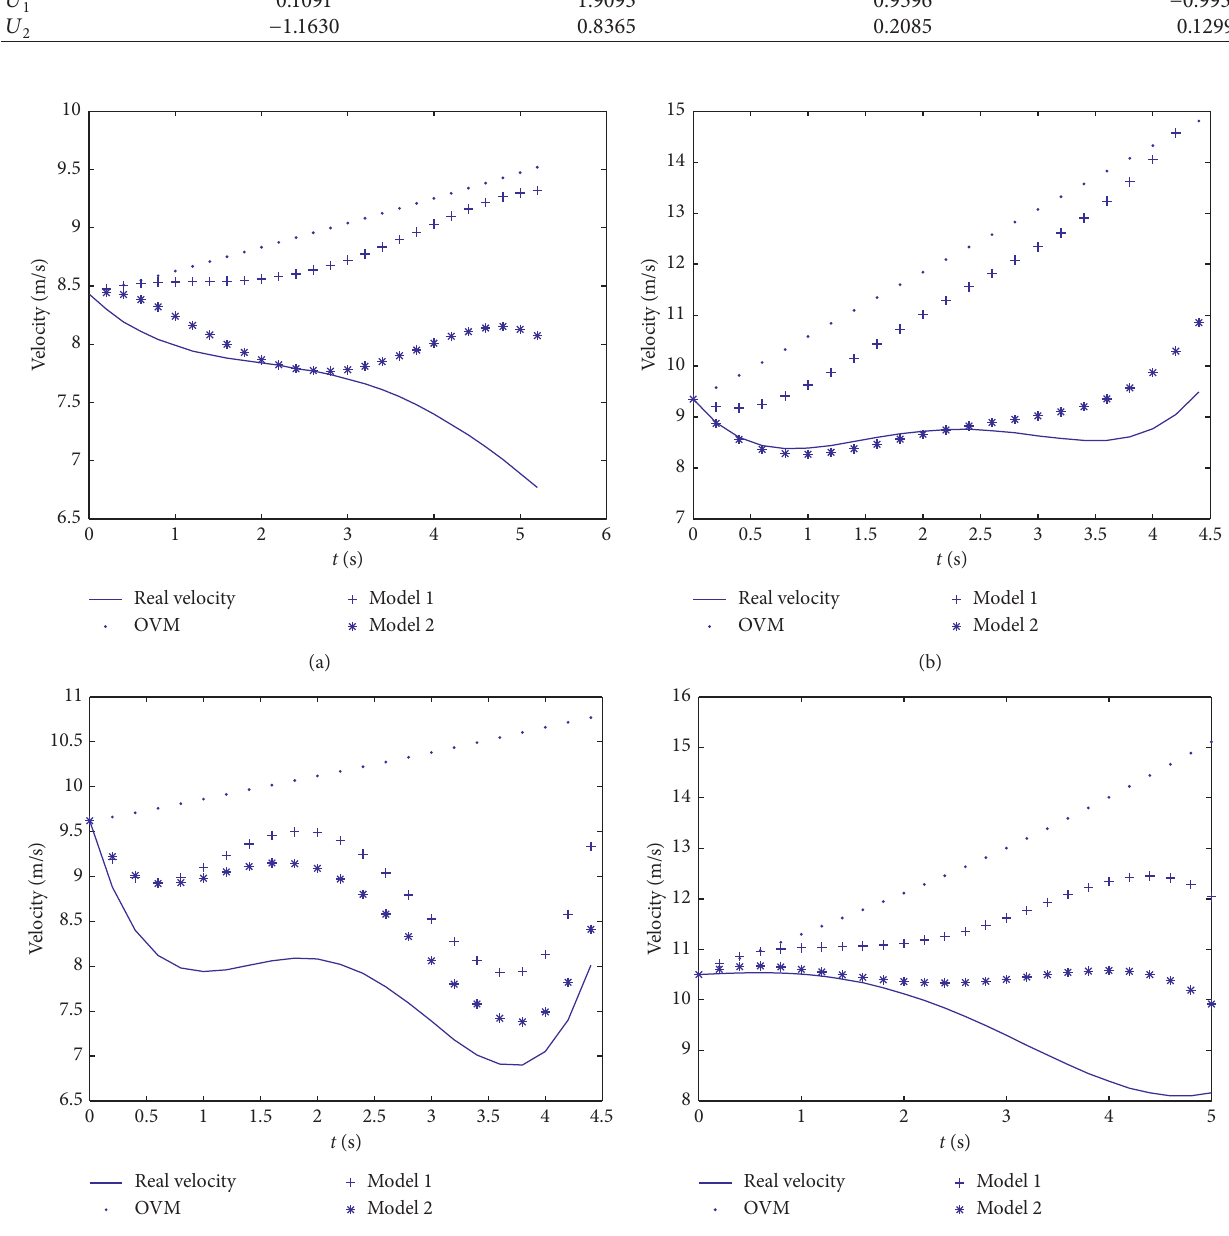
Figure 6: Comparison of simulation result: (a) the first sets of data; (b) the second sets of data; (c) the third sets of data; (d) the fourth sets of